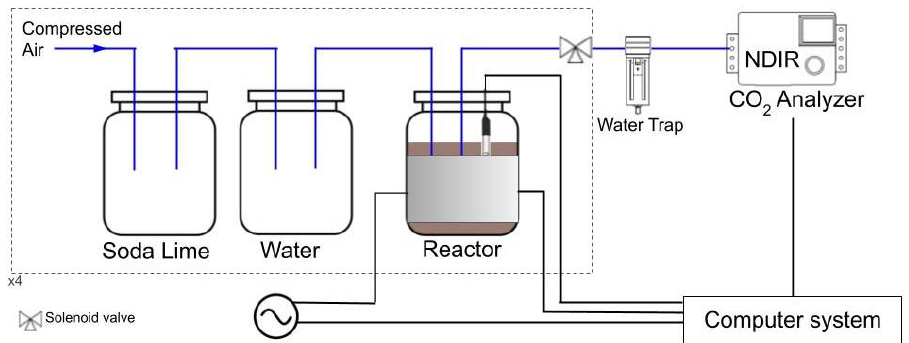
Figure 1. Schematic drawing of direct measurement respirometric system.